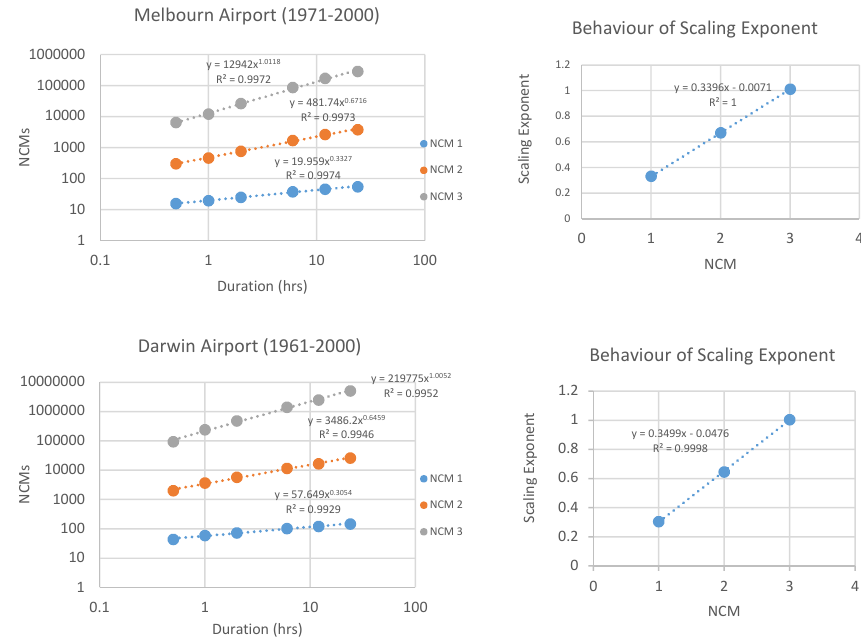
Figure 6. Assessing the behaviour of scaling exponents of observed rainfalls of Adelaide airport, Brisbane regional, Sydney observatory hill, Perth airport, Melbourne airport and Darwin airport rain gauge